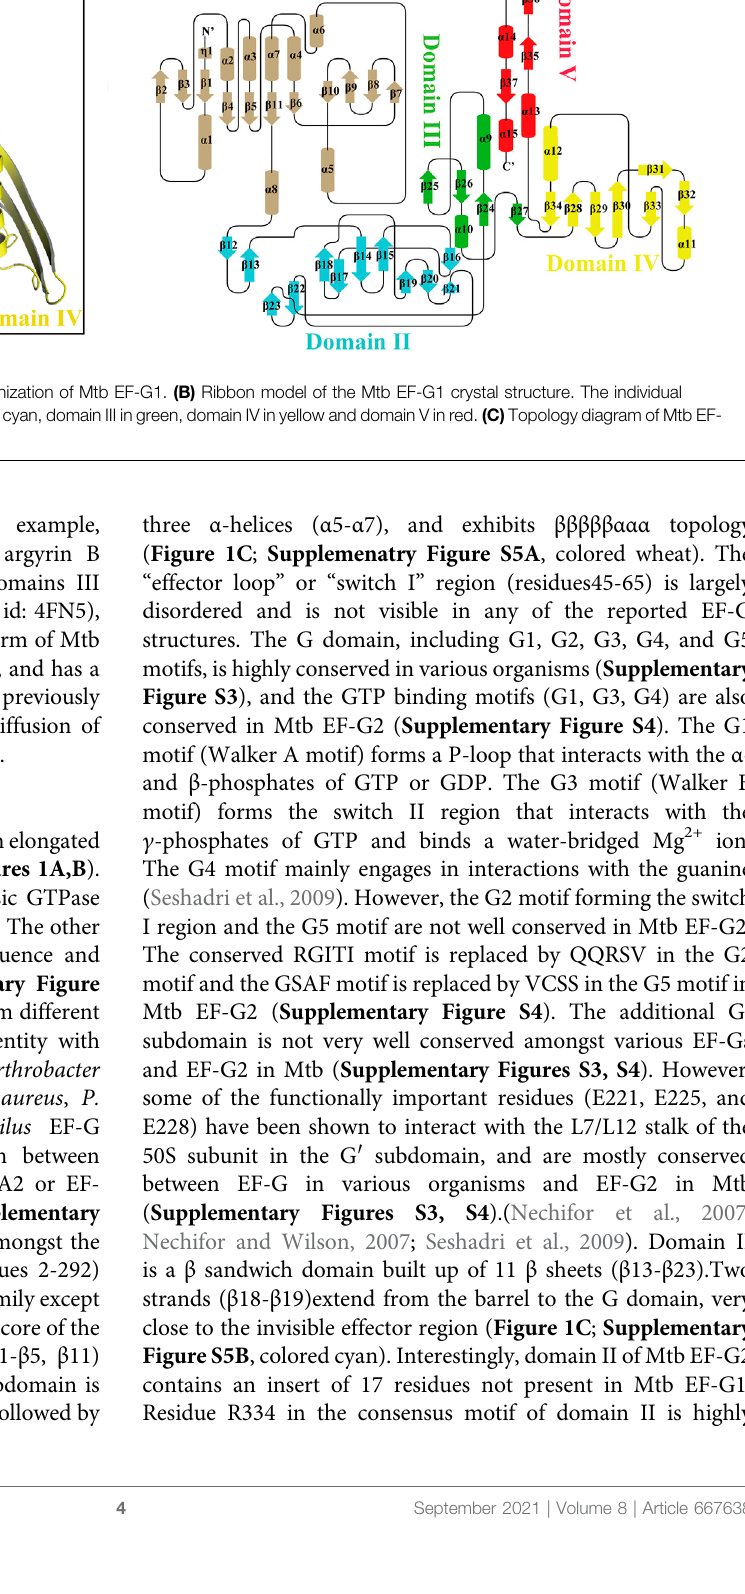
three α -helices ( α 5- α 7), and exhibits βββββααα topology